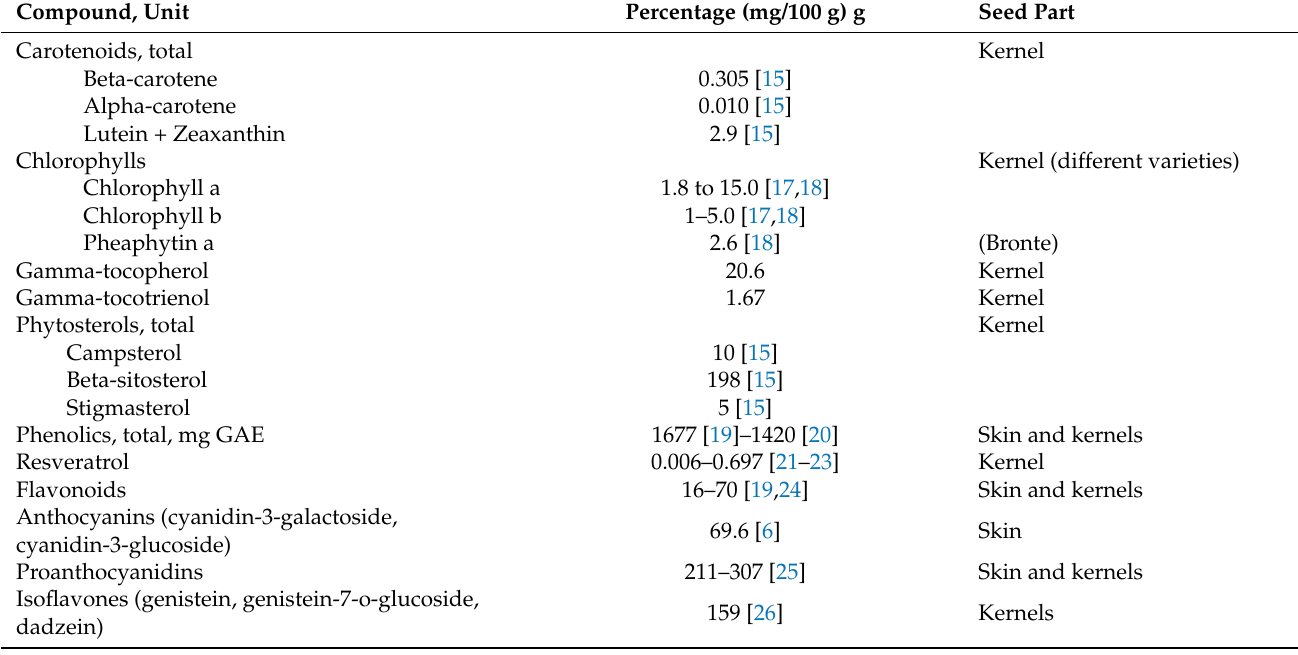
Table 3. Bioactive compounds in